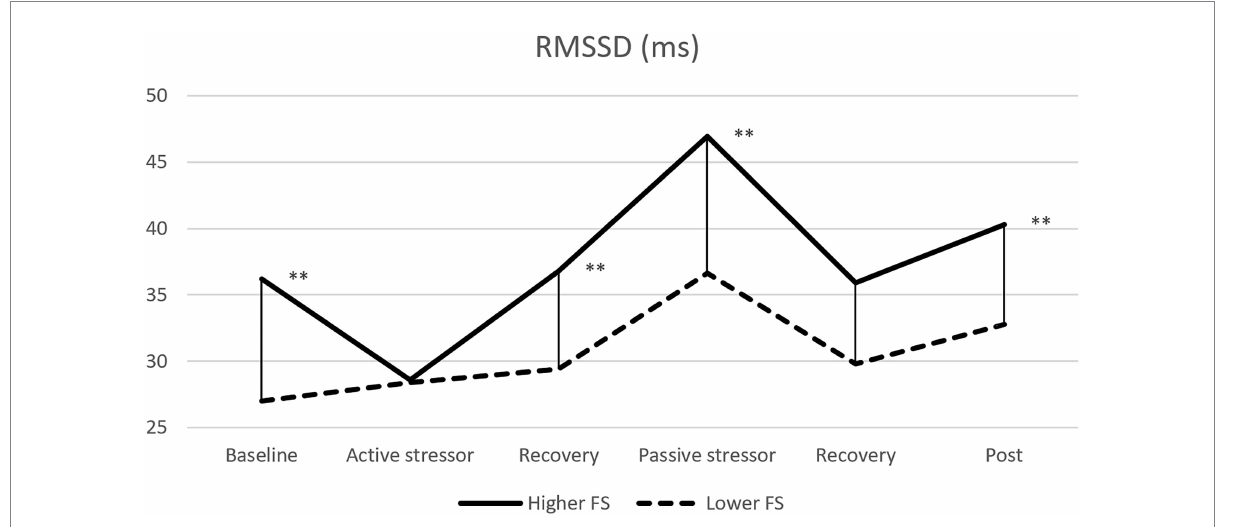
FIGURE 1 Comparisons of RMSSD reactivity in all stages between the higher and lower FS groups. ** p <